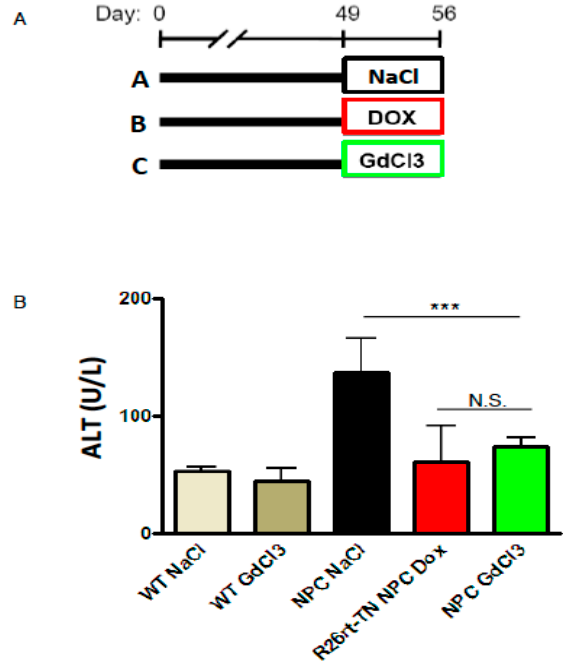
Figure 4. Foam-cell-associated NPC liver pathology is improved by GdCl 3 treatment. ( A ) Timeline of the duration and age of different treatments in mice. ( B ) Alanine transaminase (ALT) levels in the different groups. Data are presented as means ± SD. ( n = 3–5 animals/group, two-way ANOVA, and Tukey’s multiple comparison post-test). *** p < 0.0001.